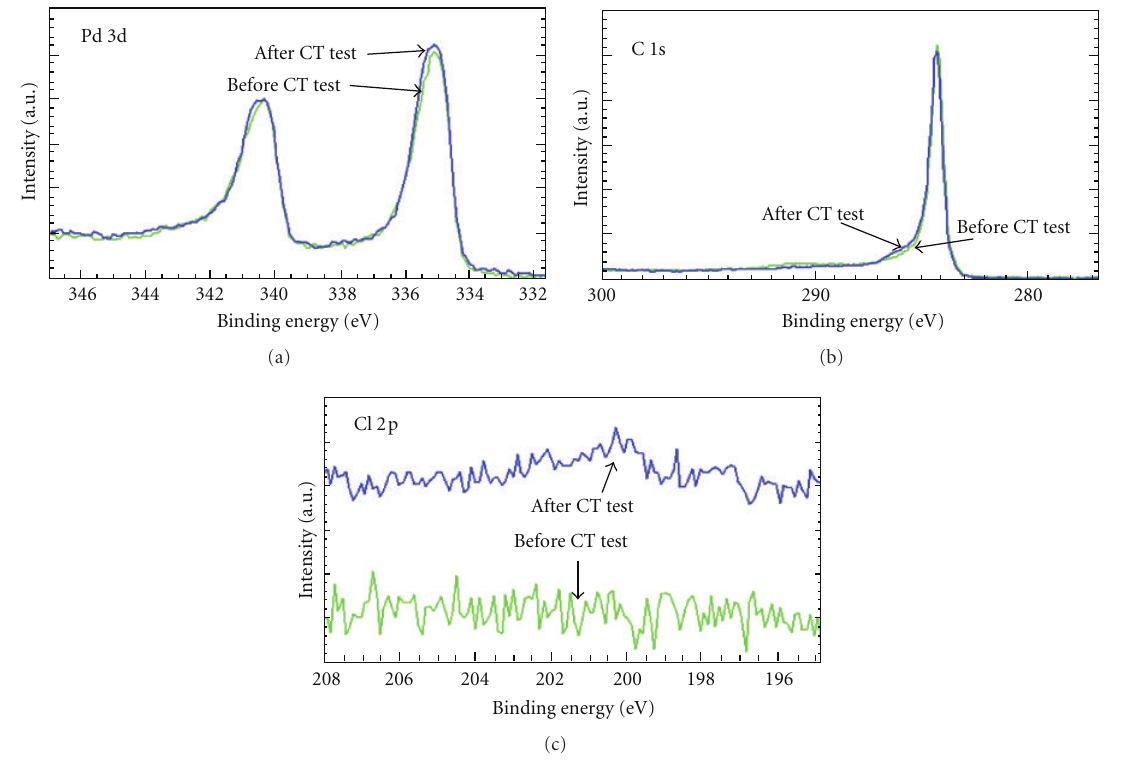
Figure 8: X-Ray photoelectron spectrometry (XPS) fine scans of (a) Pd 3d spectra, (b) C 1s spectra, and (c) Cl 2p spectra, obtained from Pd/CNT/Foam sample, before (green line) and after (blue line) the carbon tetrachloride (CT) dechlorination